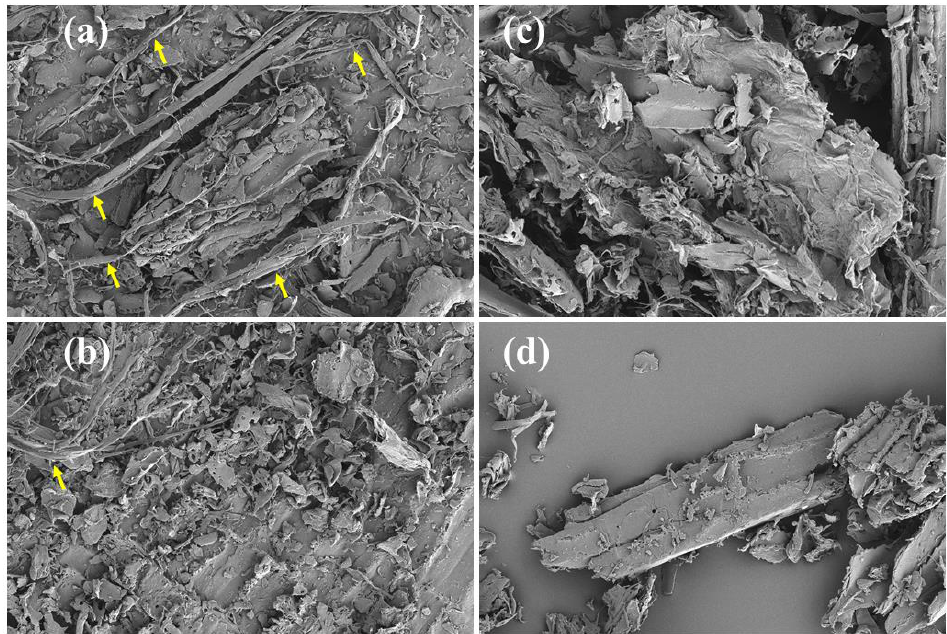
Figure 2. SEM image of ( a ) raw and pretreated ( b ) AH, ( c ) TH, and ( d ) TCH solid residues of IHR. Arrows show fibers in